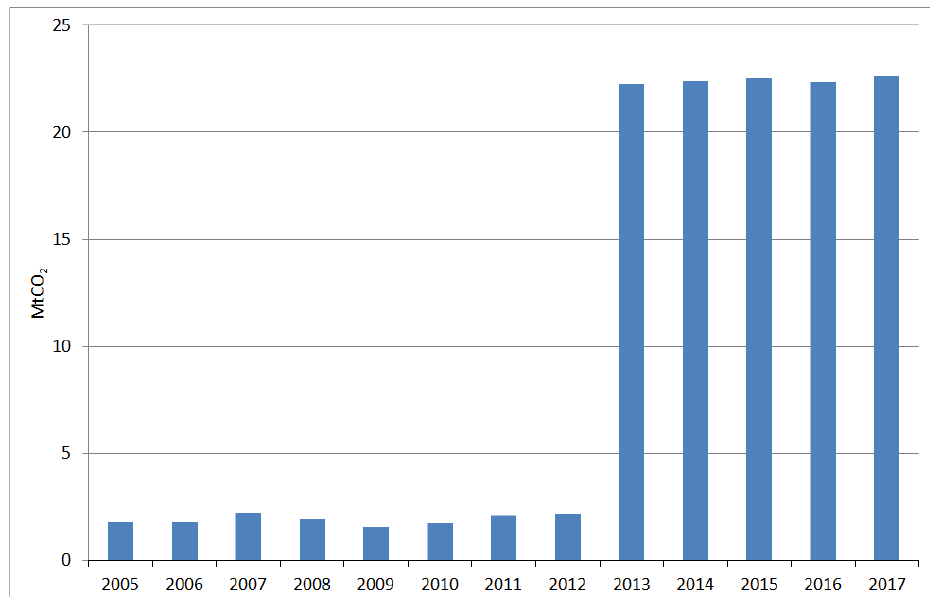
Figure 9. Overall greenhouse gas emissions of ammonia in the EU EUTL data. Source: Activity 41 (ammonia) [25].